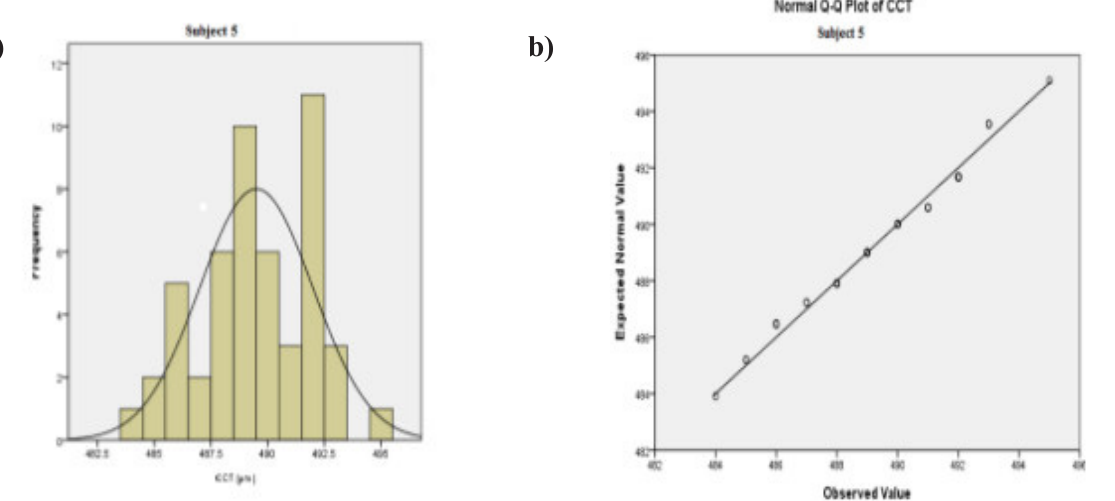
Figure 3: Histograms ( a ) and normal probability ( b ) plots for the CCT sample of subject 5. The samples were normally distributed (the p- values for the K-S, Lilliefors and S-W tests were all greater than 0.05).